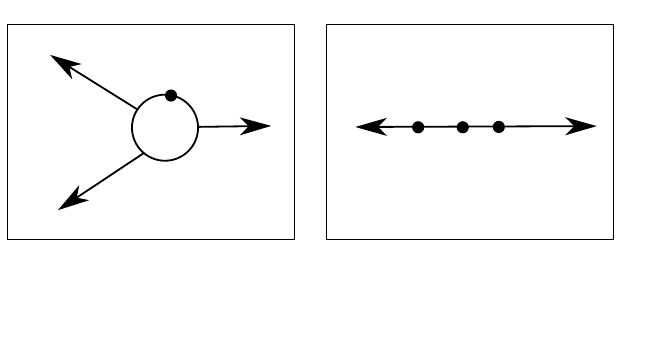
Figure 4.6: Arcs linking more than two interactor nodes are attached to a circle and outcomes of an interaction are not allowed to